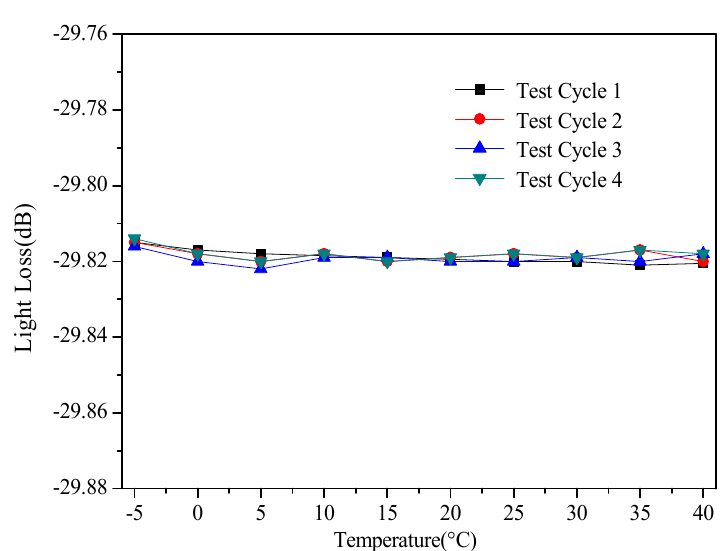
ff erent Figure 10. POFS performance test at different temperatures. Figure 10. POFS performance test at di Figure 10. POFS performance test at different temperatures.